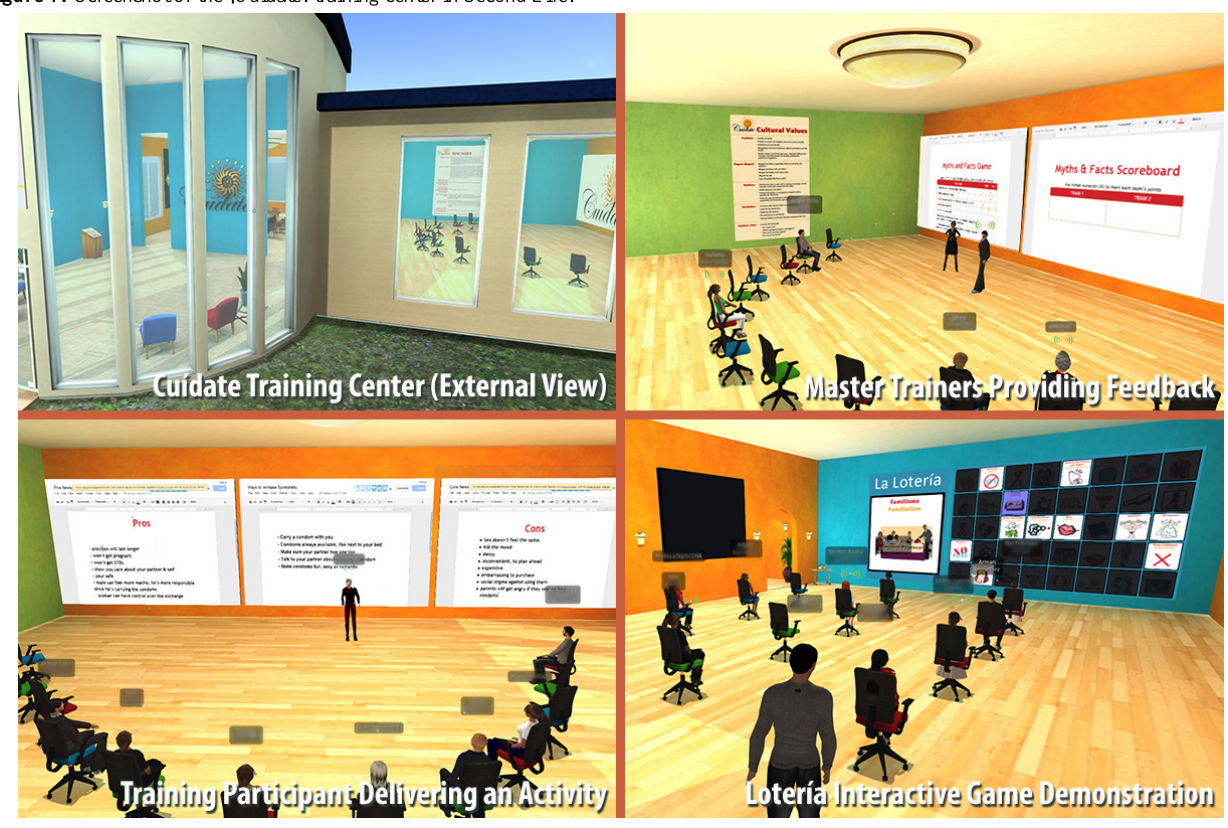
Figure 1. Screenshot of the ¡Cuídate! training center in Second